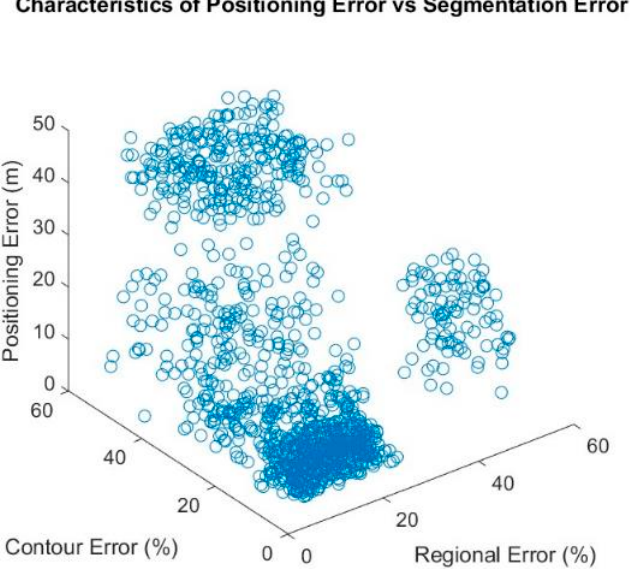
Figure 3. The effects of contour-based error and regional-based error on the positioning error of the proposed semantic-based VPS.